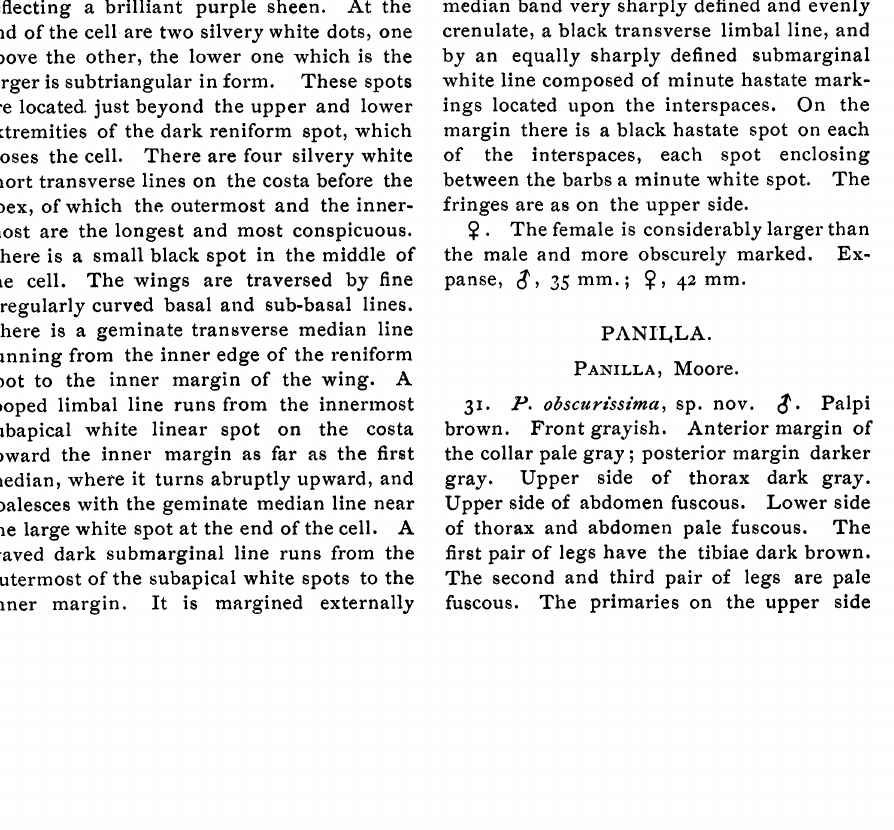
brown. Front grayish. Anterior margin of the collar pale gray; posterior margin darker gray. Upper side of thorax dark gray. Upper side of abdomen fuscous. Lower side of thorax and abdomen pale fuscous. first pair of legs have the tibiae dark